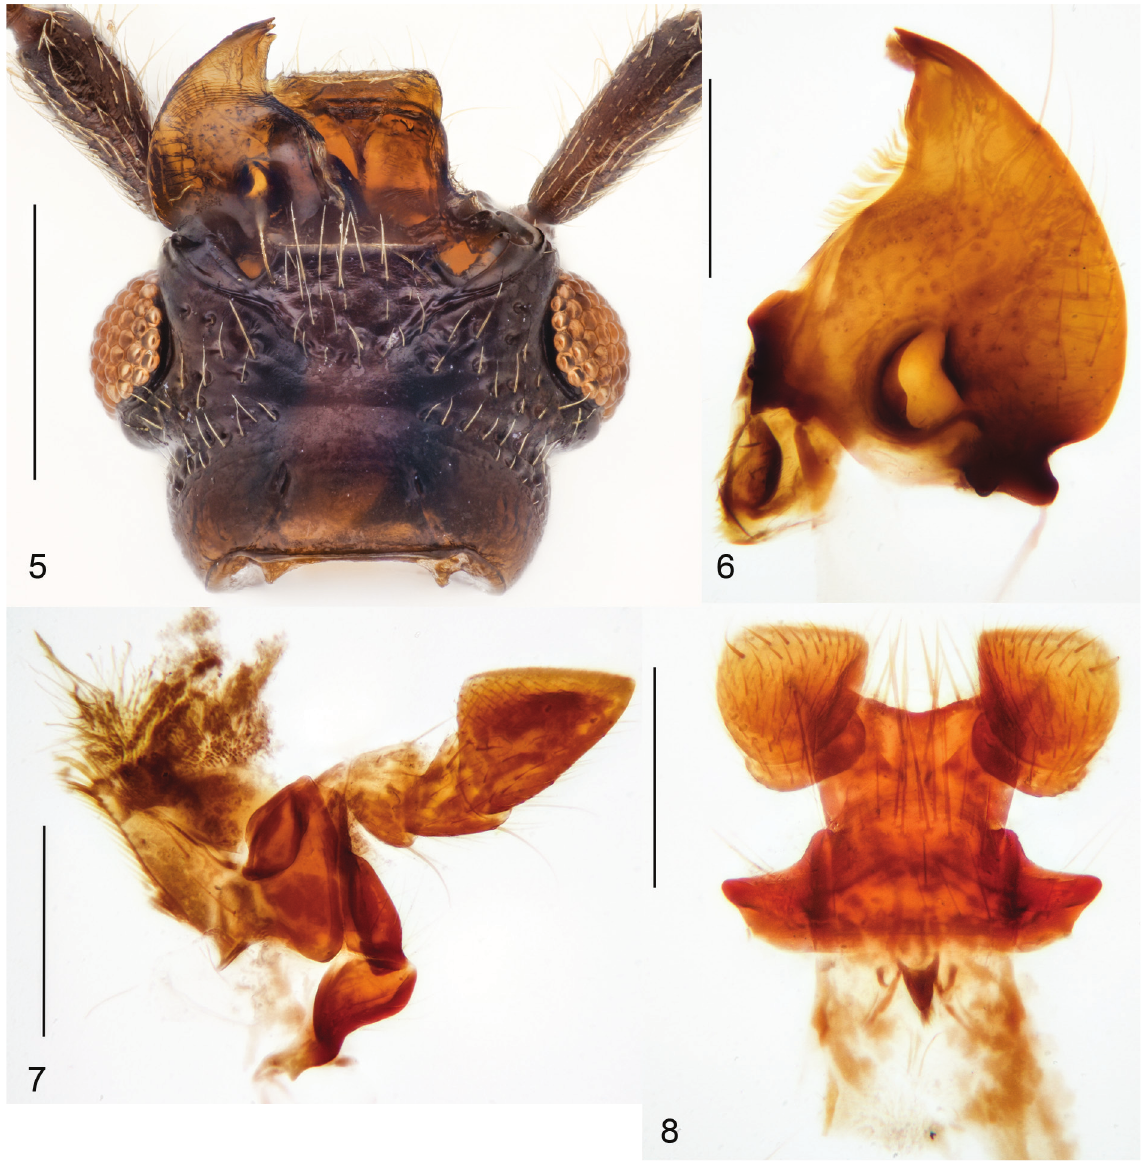
Figs 5–8. Bolianus giannae gen. et sp. nov., paratype. 5 . ventral view of head (left mandible, maxillae and labium removed). 6 . left mandible, ventral view. 7 . left maxilla, ventral view. 8 . labium, ventral view. Scale bars: 5 = 0.5 mm, 6–8 = 0.2